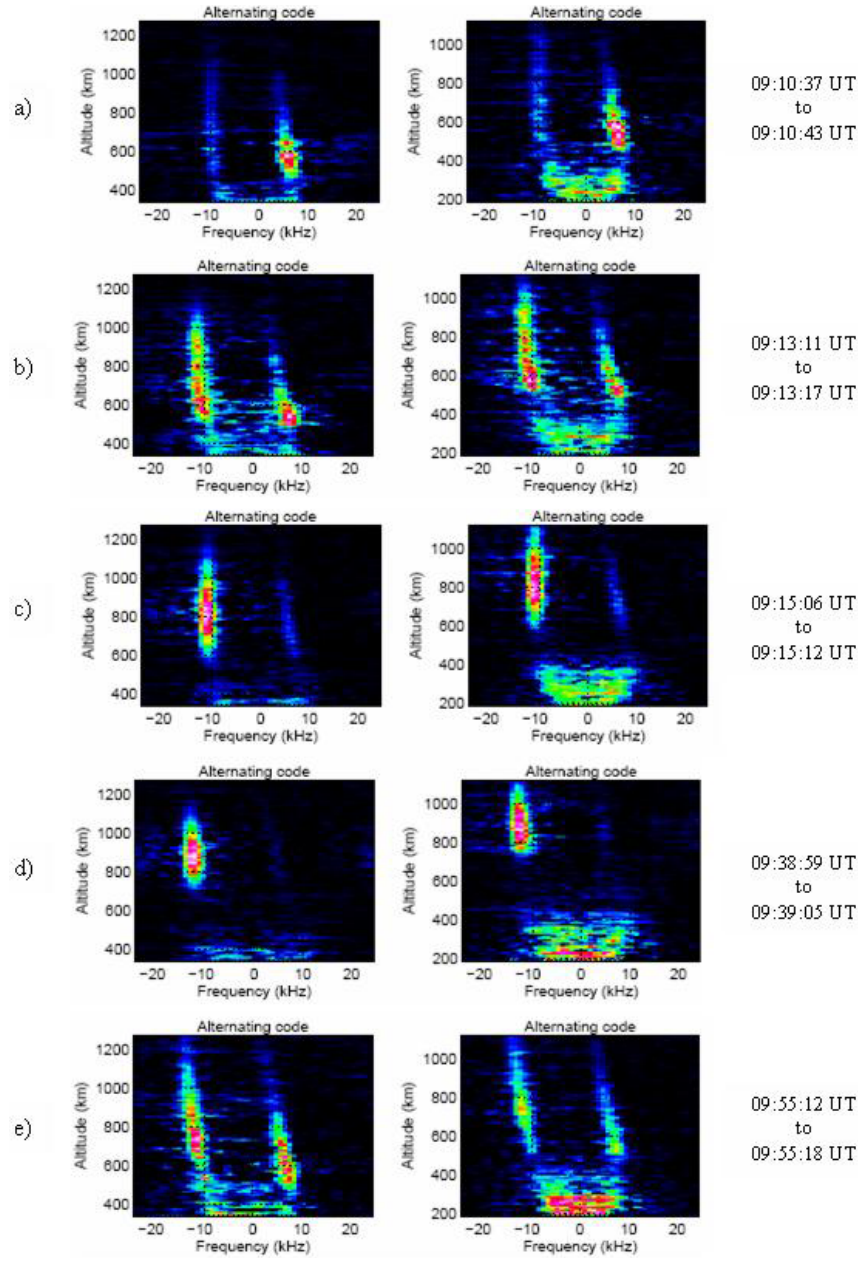
Fig. 2. Examples of some of the NEIALs observed between ∼ 08:52 and ∼ 09:55 UT, with enhancement in one or both shoulders; (a) the right shoulder is much more enhanced than the left, (b) both shoulders are enhanced to about the same level, (c) the left shoulder is much more enhanced than the right, (d) a more height defined enhancement in the left shoulder and (e) the enhancement in both shoulders are left shifted (strong ion outflow). Start and stop of the integration time are given on the right hand